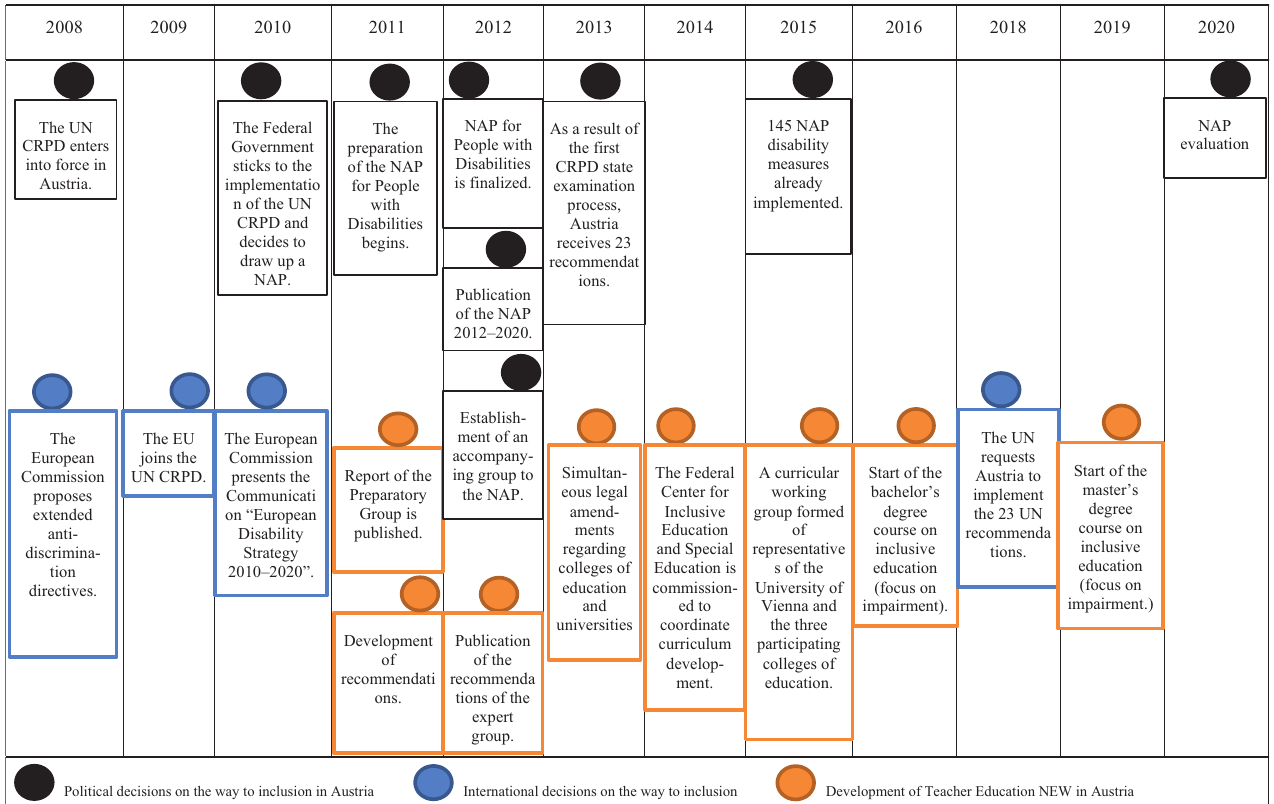
TABLE 1 | Historical overview as results of the preparation process of the